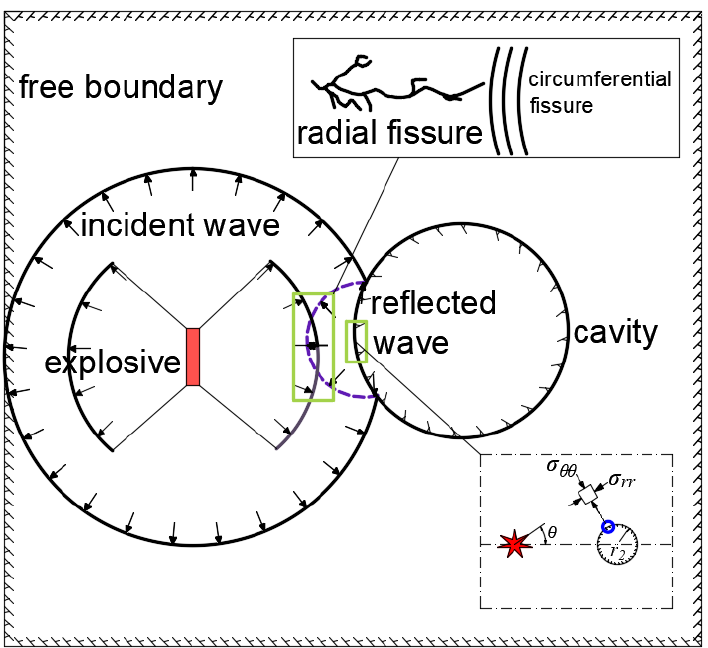
Figure 11. The existence of voids leads to the change mechanism of the resistance line.